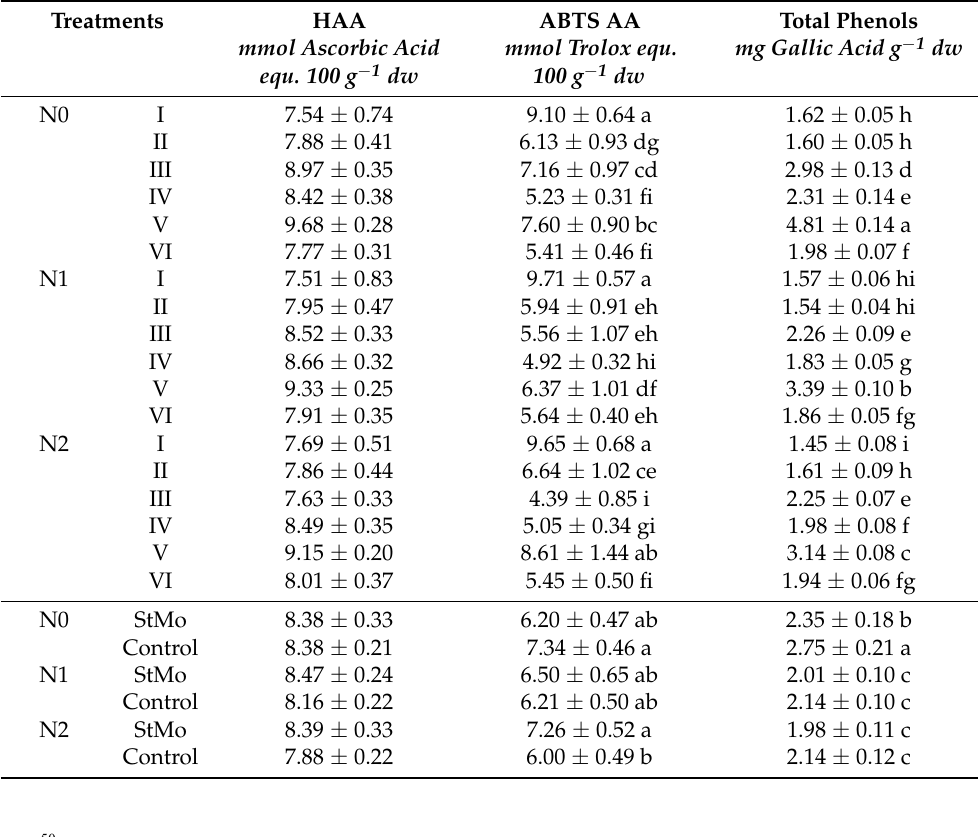
Table 8. Interactions nitrogen fertilization × harvest (F × H) on the average hydrophilic antioxidant activity (HAA), ABTS antioxidant activity (ABTS AA) and content of total phenols in rocket. Different letters within each column indicate significant differences at p = 0.05 (Tukey’s test).